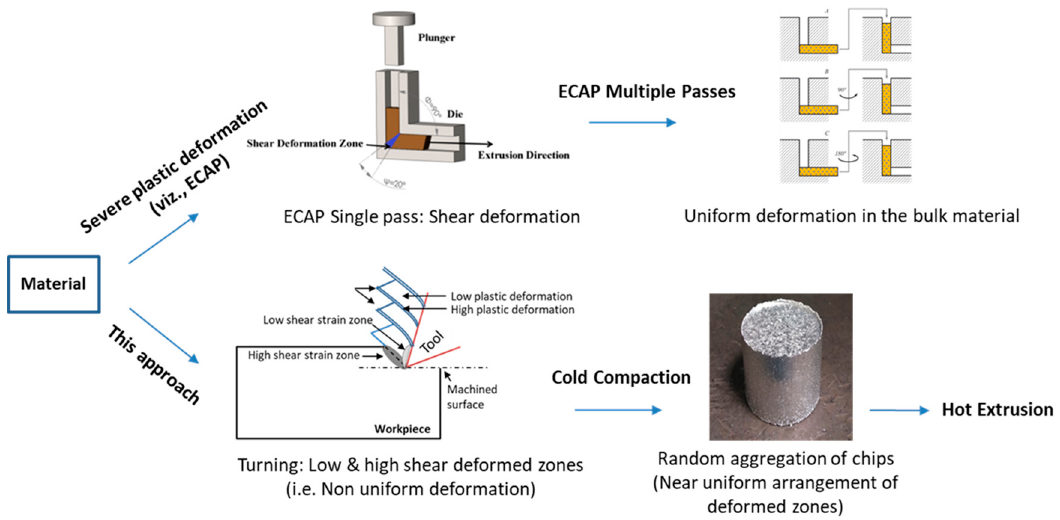
Figure 1. Mechanism of this approach vs. ECAP (equal channel angular pressing).